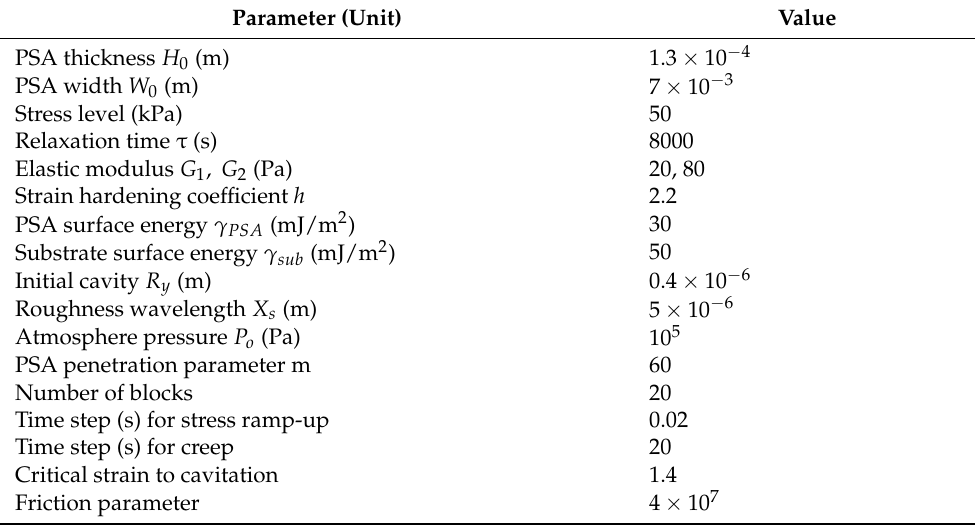
Table 2. Simulation